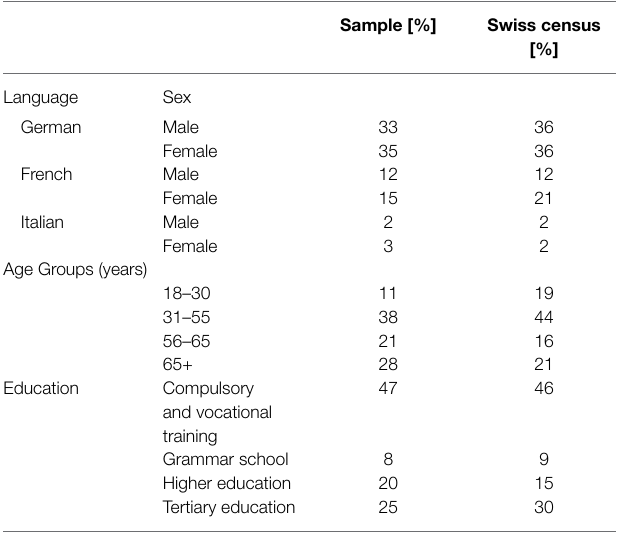
TABLE 4 | Analysis of the response rate differentiated by language and gender, age groups, and educational